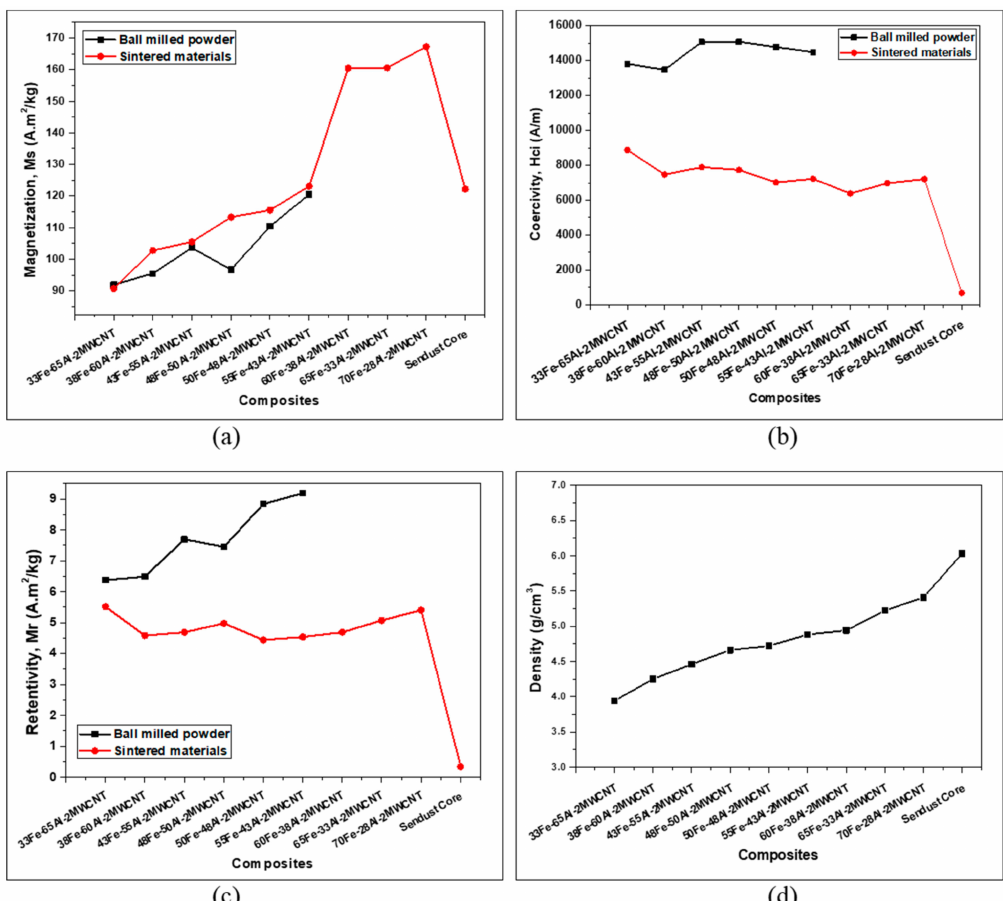
Figure 6. Magnetic properties and density of Fe-Al-MWCNT nanocomposites: ( a ) Saturation magnetization; ( b ) Coercivity; ( c ) Retentivity; and ( d ) Volume